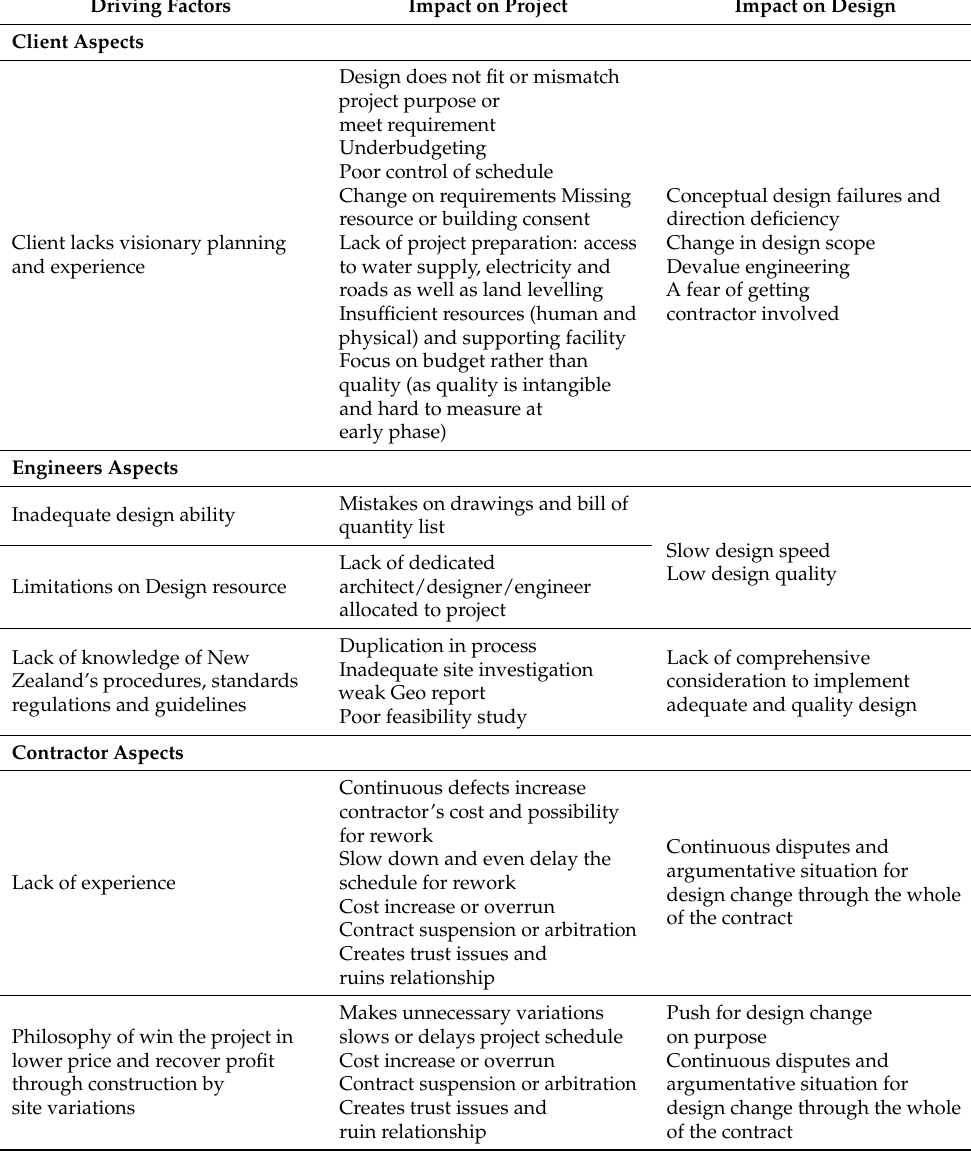
Table 3. Direct factors result in design